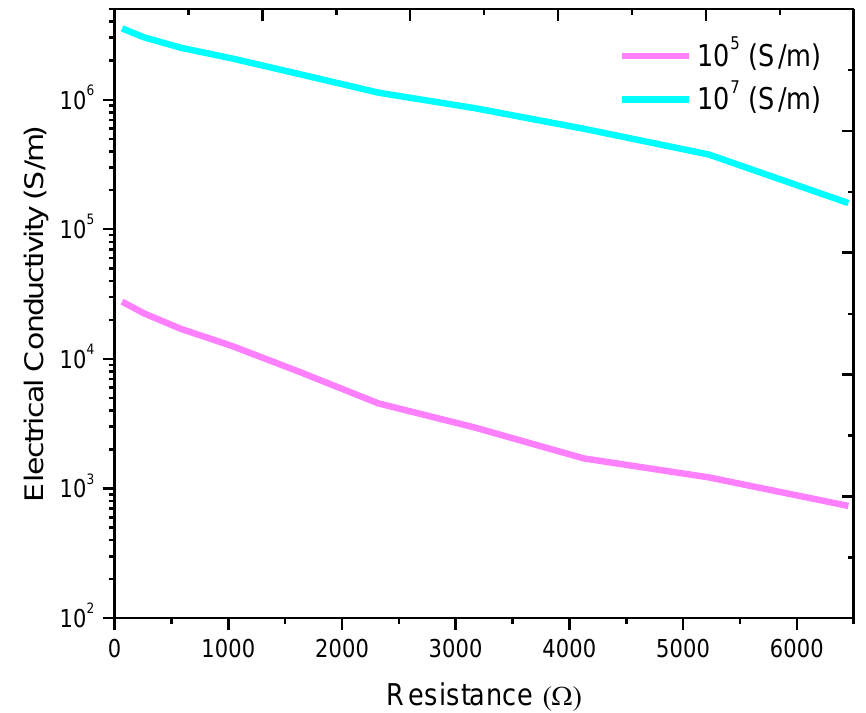
Figure 9. Tunneling effect on the electrical conductivity of the graphene–PPy composite. Furthermore, in this study, the developed model was validated by reported measure- ments. Kim et al. [37] carried out a homogenous dispersion of multiple fillers (graphene, carbon black, and CNTs) on cyclic butylene terephthalate (CBT), obtained by powder mixing and in-situ polymerization (8 data points). The synthesis methods were appropriate for homogenous dispersion of fillers in the polymer matrix. The electrical conductivi- ties of the CBT and graphene nanoplatelets were 8.50 × 10 − 14 S/m and 10 5 S/m [37], respectively. The diameter, insulation thickness, and length of the carbon black [37] were 5 µ m, 3 nm, and 6 nm, respectively. Figure 10 compares the results of the developed model in this study to the measurement results of Kim et al. [37]; they agree reasonably well. To further confirm the robustness of the model, the results of a set of experimental electrical conductivity measurements of the graphene-polystyrene (graphene–PS) compos- ite (10 data points), carried out by Stankovich et al. [36], were compared to the results of the developed model. The solvent mixing method was employed by Stankovich et al. [36] to uniformly disperse the graphene in the polymer matrix. After the filtration of the mixture of the composite from the solvent, it was washed with 200 mL of methanol. At a filler volume fraction of 0.1%, the composite electrical conducting path was formed. For the developed model, the diameter, length, insulation thickness, and initial conductivities of graphene and PS were 50 µ m, 2 nm, 3 nm, 10 2 S/m, and 10 − 15 S/m, respectively. Figure 11 compares the electrical conductivity measurement results reported by Stankovich et al. [36] to those of the model developed in this study. The obtained results agree reasonably well with the measurement results